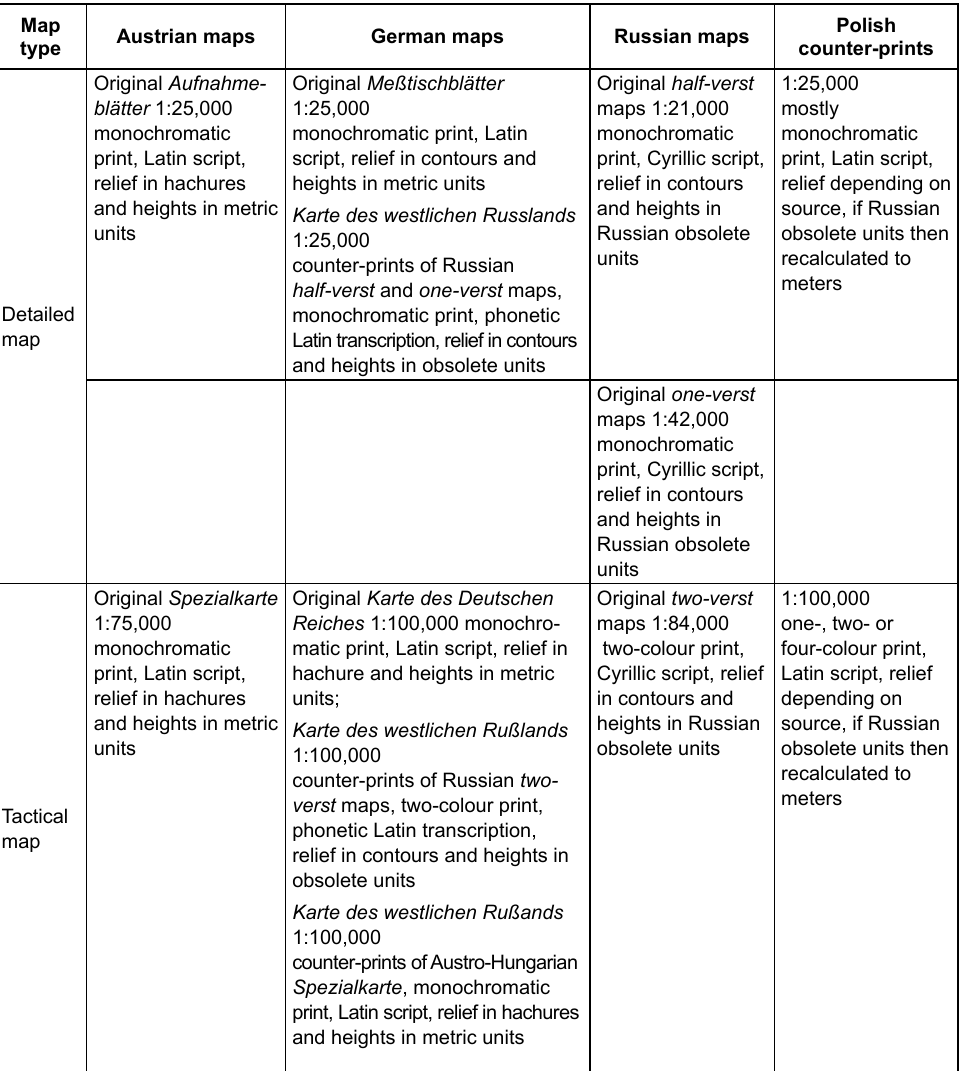
raster images of all 480 tactical map sheets covering Interwar Poland. Only 346 of gathered sheets were printed after 1930. The query con- firmed that 72% of the country was covered by